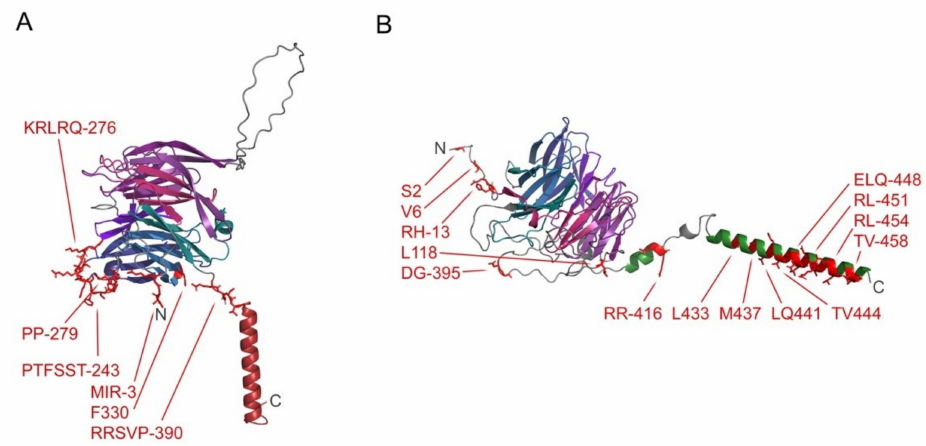
Figure 9. Structural models of WD repeat proteins showing their membrane docking sites. The PREB ( A ) and COR1A ( B ) structural models from AlphaFold2 and Rosetta, respectively, are shown with the seven WD repeats of their β propeller domains colored pink, violet, medium and dark purple and blue, and teal. The TM helix of PREB is vertically oriented dark red, while the membrane-interactive helical extension (HE) in COR1A is green and roughly horizontal. The rest of the backbone ribbon residues are gray. The peripheral residues displaying significant membrane binding propensities are drawn in red as sticks and labelled. The N- and C-termini are